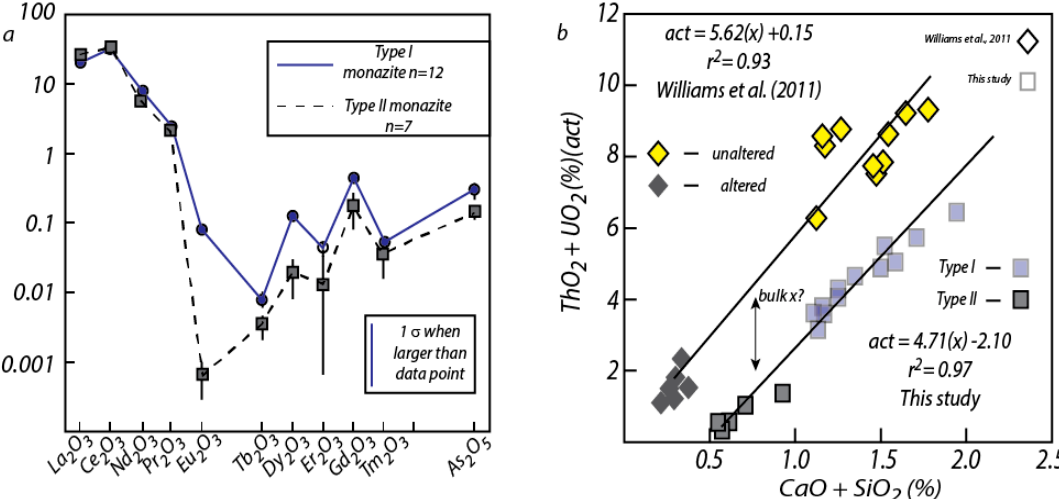
Figure 5. ( a ) REE concentrations of averaged Type I and Type II monazite in this study ( y -axis in wt. %); ( b ) Actinides vs. CaO + SiO 2 in both Type I and Type II monazite compared to experimental results in [3].